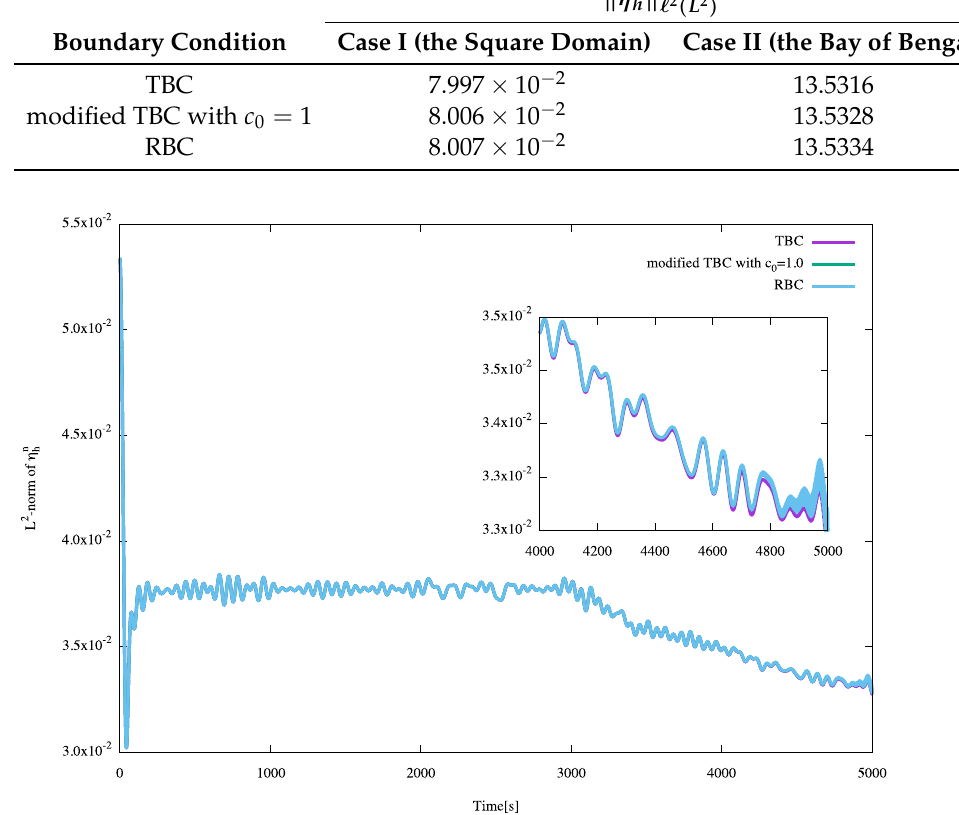
Figure A1. Graphs of L 2 ( Ω ) -norm of η n